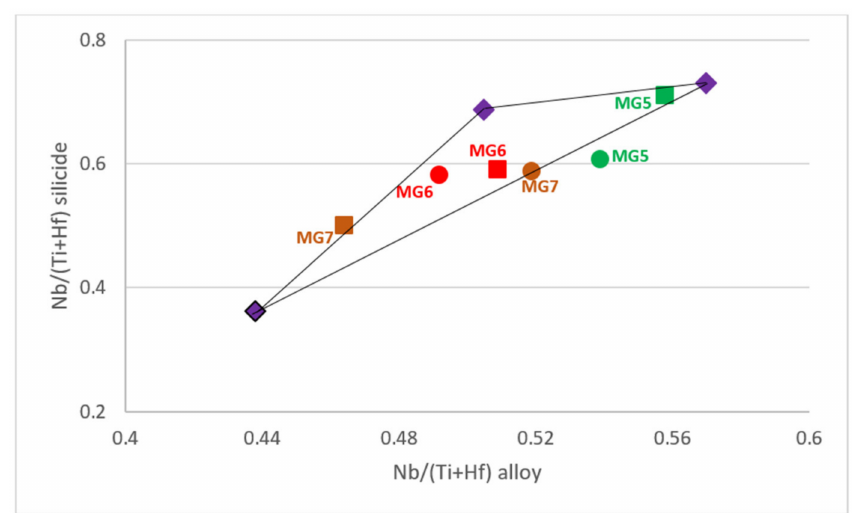
Figure 2. [Nb/(Ti + Hf)] Nb5Si3 versus [Nb/(Ti + Hf)] alloy map for Nb-Ti-Si-Al-Hf alloys that are predicted by NICE [27] to form hexagonal γ Nb 5 Si 3 , have no Nb ss and weight gains per unit area less than or equal to 1 and 10 mg/cm 2 after 100 h isothermal oxidation respectively at 800 and 1200 ◦ C. Squares show the values corresponding to the nominal compositions and the circles show the actual compositions in all parts of the alloys Nb 1.45 Si 2.7 Ti 2.25 Al 3.25 Hf 0.35 (MG5), Nb 1.35 Si 2.3 Ti 2.3 Al 3.7 Hf 0.35 (MG6) and Nb 1.3 Si 2.4 Ti 2.4 Al 3.5 Hf 0.4 (MG7